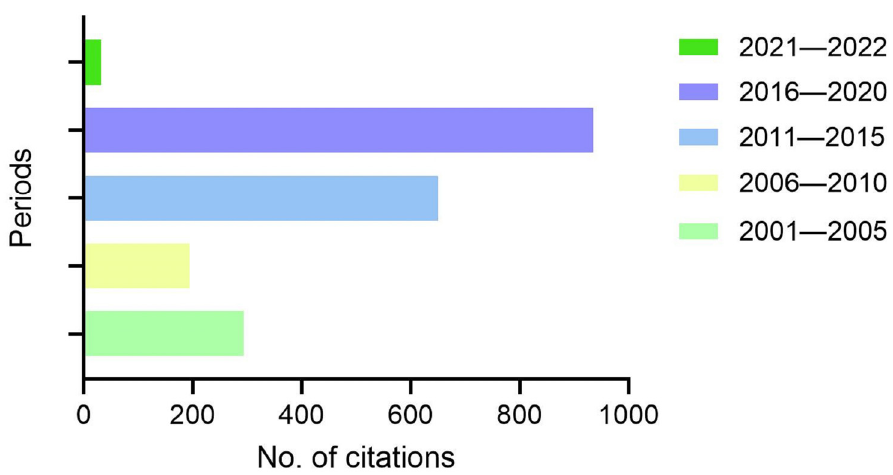
Figure 3. Absolute number of citations of Brazilian scientific publications involving use of molecular biology to understand the mechanisms triggered by plant–diazotrophic bacteria interaction in the period 2001–2022 (Source: Web of science—www.webofscience.com/wos/author/search, accessed on 28 August 2022).